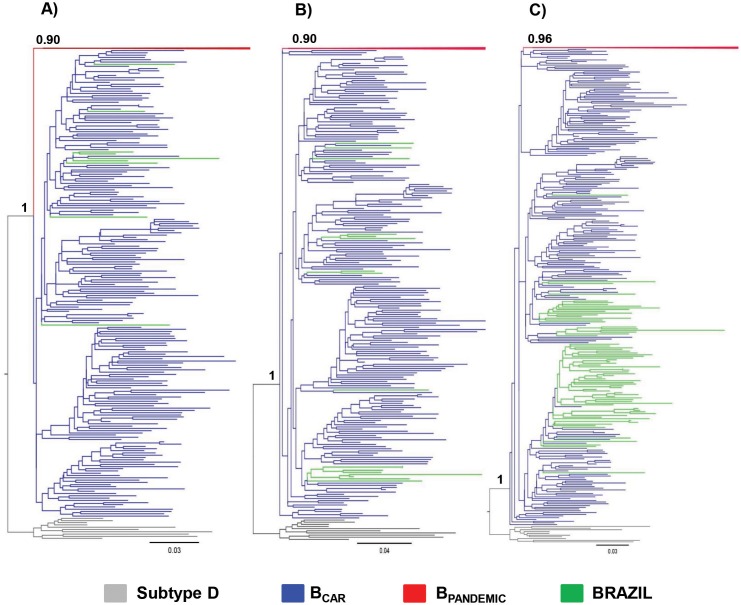
ML phylogenetic tree of HIV-1 subtype B pol PR/RT sequences (~1,000 nt) circulating in Brazil (n = 2,682) and representative sequences of the BPANDEMIC (n = 300) and the BCAR (n = 200) clades.Brazilian subtype B pol sequences were subdivided in three subsets according to their geographic origin: A) sequences from Sao Paulo, B) sequences from the Central-Western/Southern/Southeastern (except Sao Paulo) regions, and C) sequences from the Northern/Northeastern regions. Branches are colored according to the geographic origin/clade classification of each sequence as indicated at the legend at bottom. The BPANDEMIC clade was collapsed for visual clarity. The aLRT support values are indicated at key nodes. Trees were rooted using HIV-1 subtype D reference sequences. The branch lengths are drawn to scale with the bar at the bottom indicating nucleotide substitutions/site.